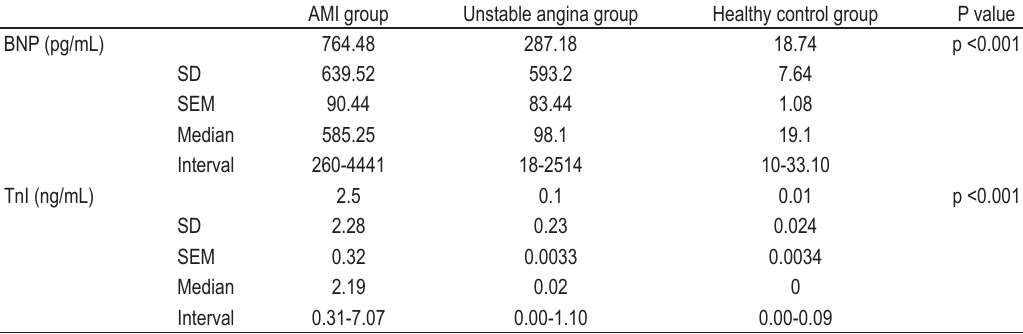
Table 1. The mean concentration of biochemical parameters in groups with AMI, unstable angina and healthy control AMI group Unstable angina group Healthy control group P value BNP (pg/mL) 764.48 287.18 SEM